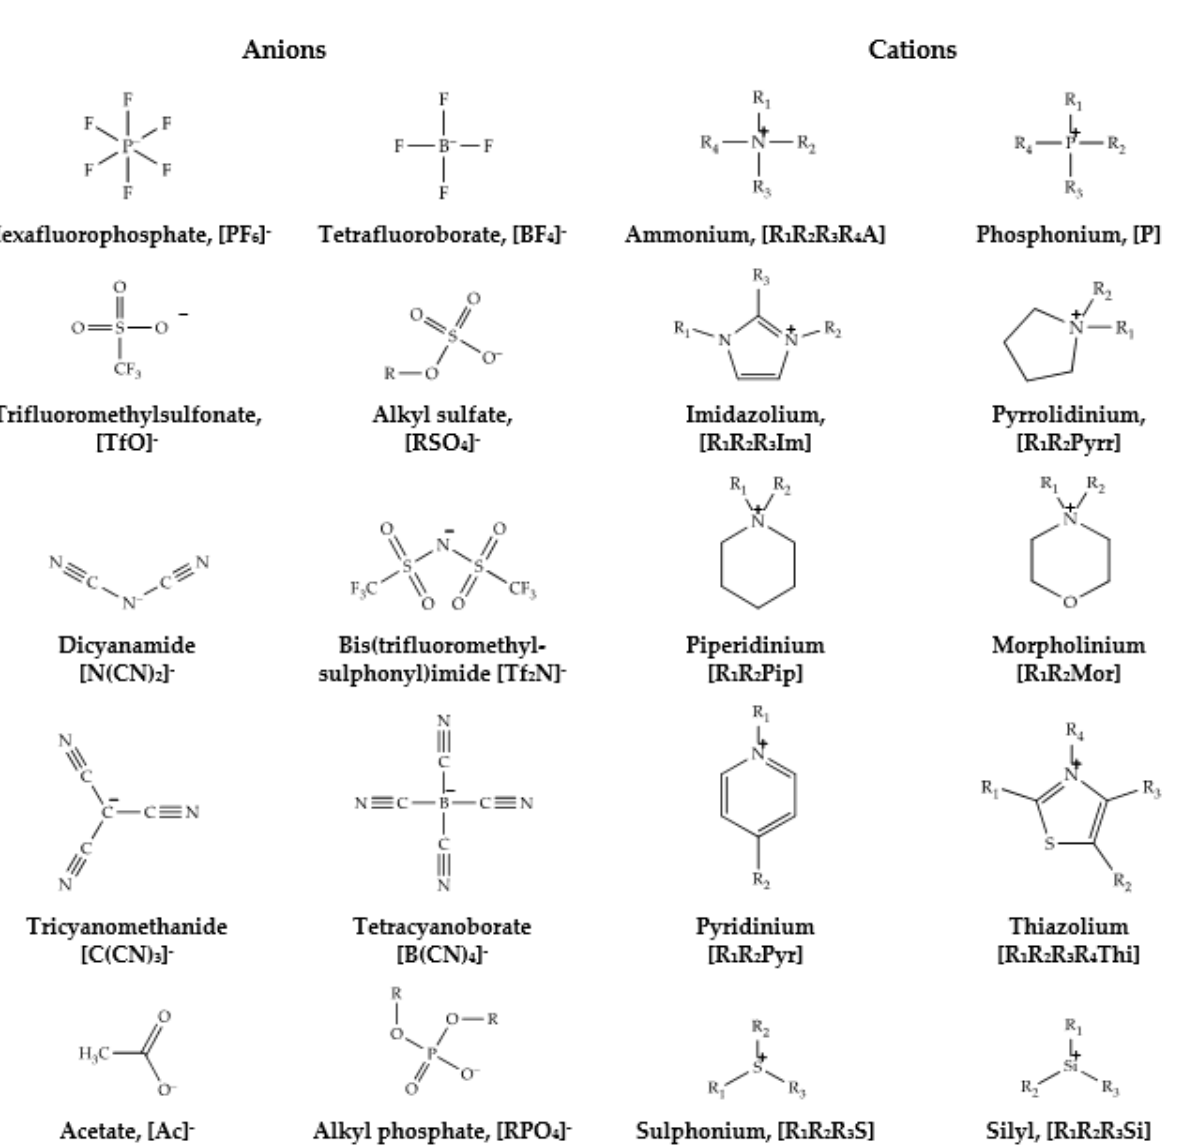
Figure 1. Overview of some of the most common anions and cations used in ion ionic liquid membranes.